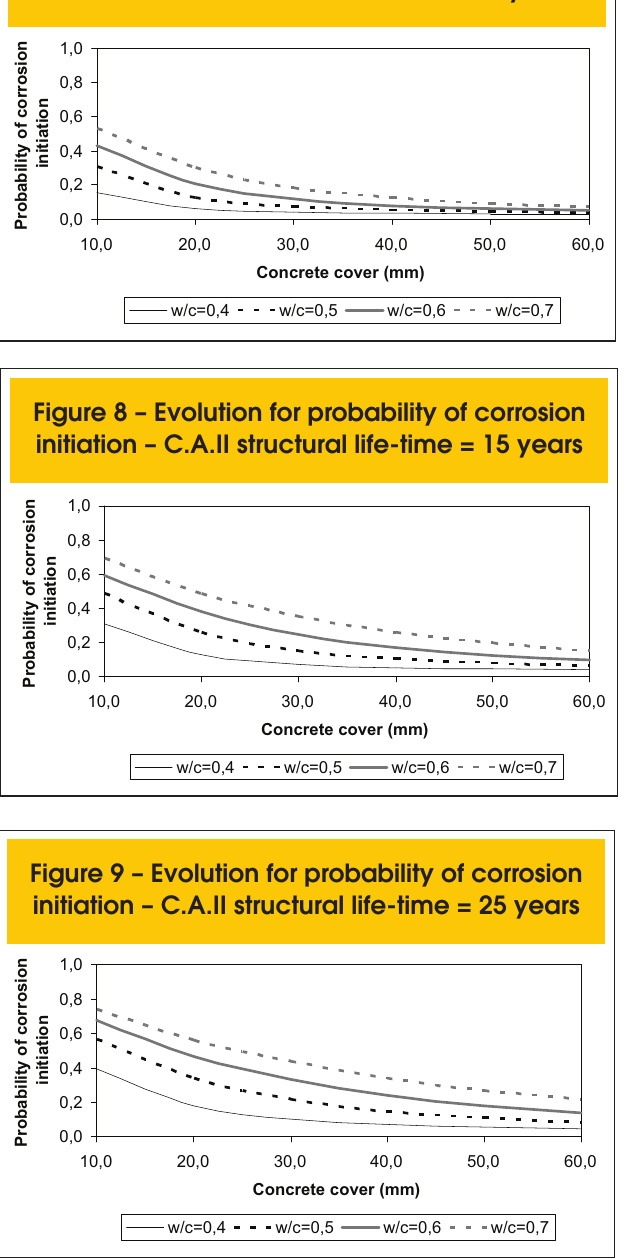
Figure 7 – Evolution for probability of corrosion initiation – C.A.II structural life-time = 5 years